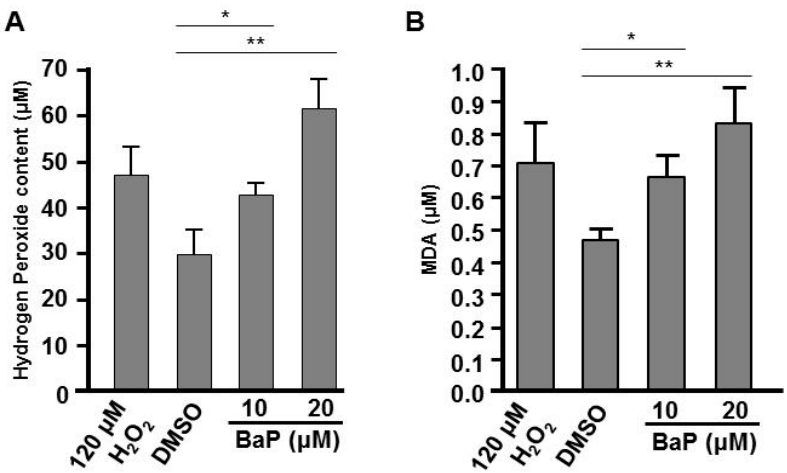
Figure 7. Exposure to B[a]P increases embryonic hydrogen peroxide and lipid peroxidation. ( A ) Embryonic hydrogen peroxide content was determined by the FOX assay and ( B ) the level of lipid peroxidation was examined by the malondialdehyde (MDA) assay. * p < 0.05, ** p <